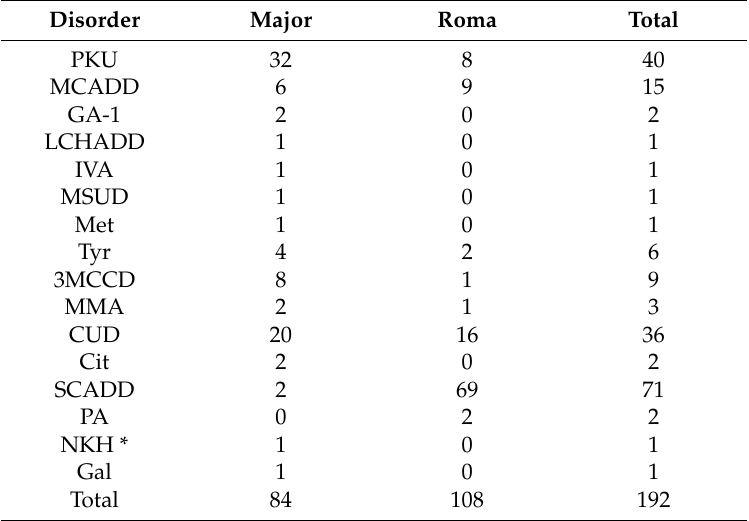
Table 4. Absolute numbers of IEMs detected by newborn screening after